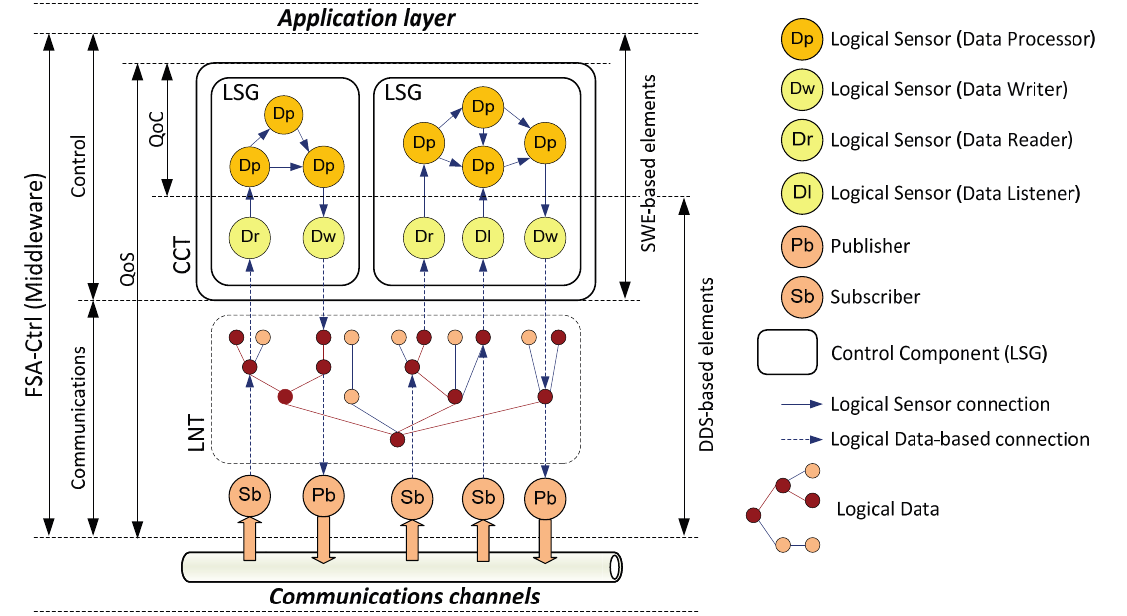
Figure 2. Components of the FSACtrl